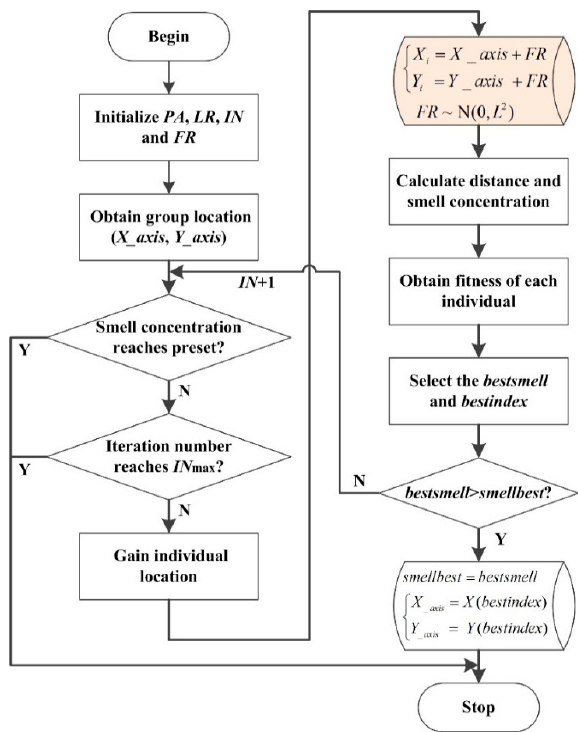
Figure 3. Flowchart of the improved fruit fly optimization algorithm.